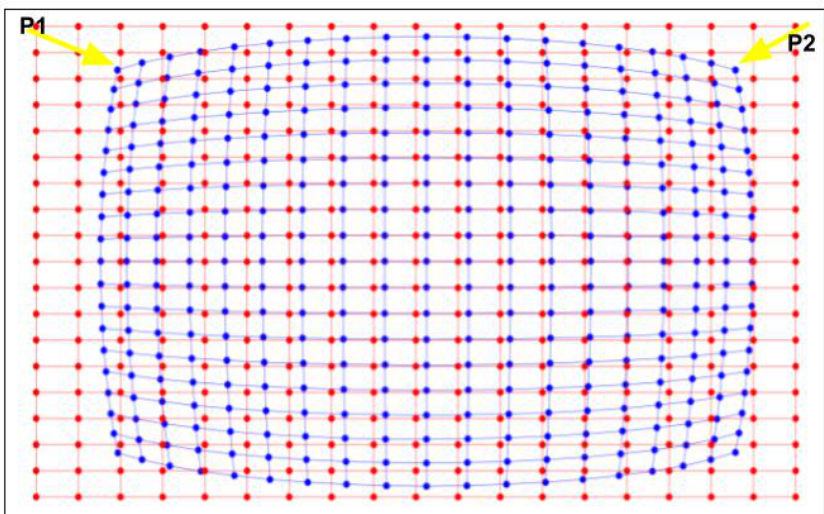
Figure 18. Optical decentring.